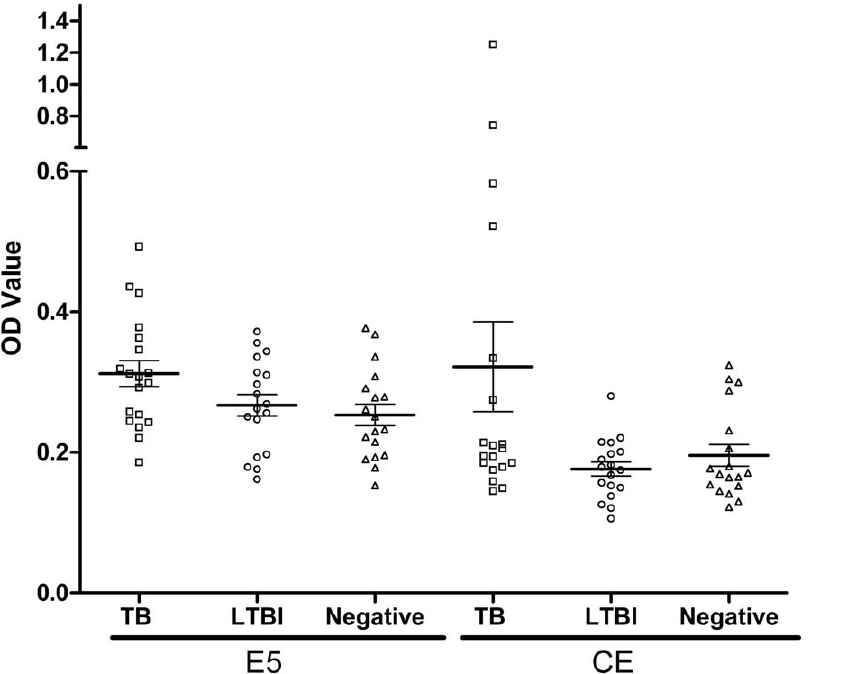
Figure 9. Scatter dot plot representation of the distribution of IgG levels to the peptide E5 and CE protein in TB patients ( % ), LTBIs ( # ) and negative controls ( n ). (Error bars: 95% confidence interval for mean). The plates were coated with 4 m g peptides E5 ml 2 1 or 1 m g CE protein ml 2 1 per well, as described in Methods. Sera from TB patients (n=19), LTBIs (n=18) and healthy individuals (n=18) were tested. The results are shown as the mean OD value of each triplicate sample read 20 min after the addition of substrate. Significant differences for three groups were determined of E5 peptides and CE protein (F=3.522, P=0.0368; F=4.026, P=0.0237).